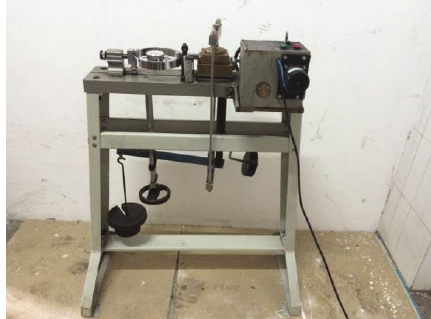
Figure 2: ZJ-type strain-controlled direct shear